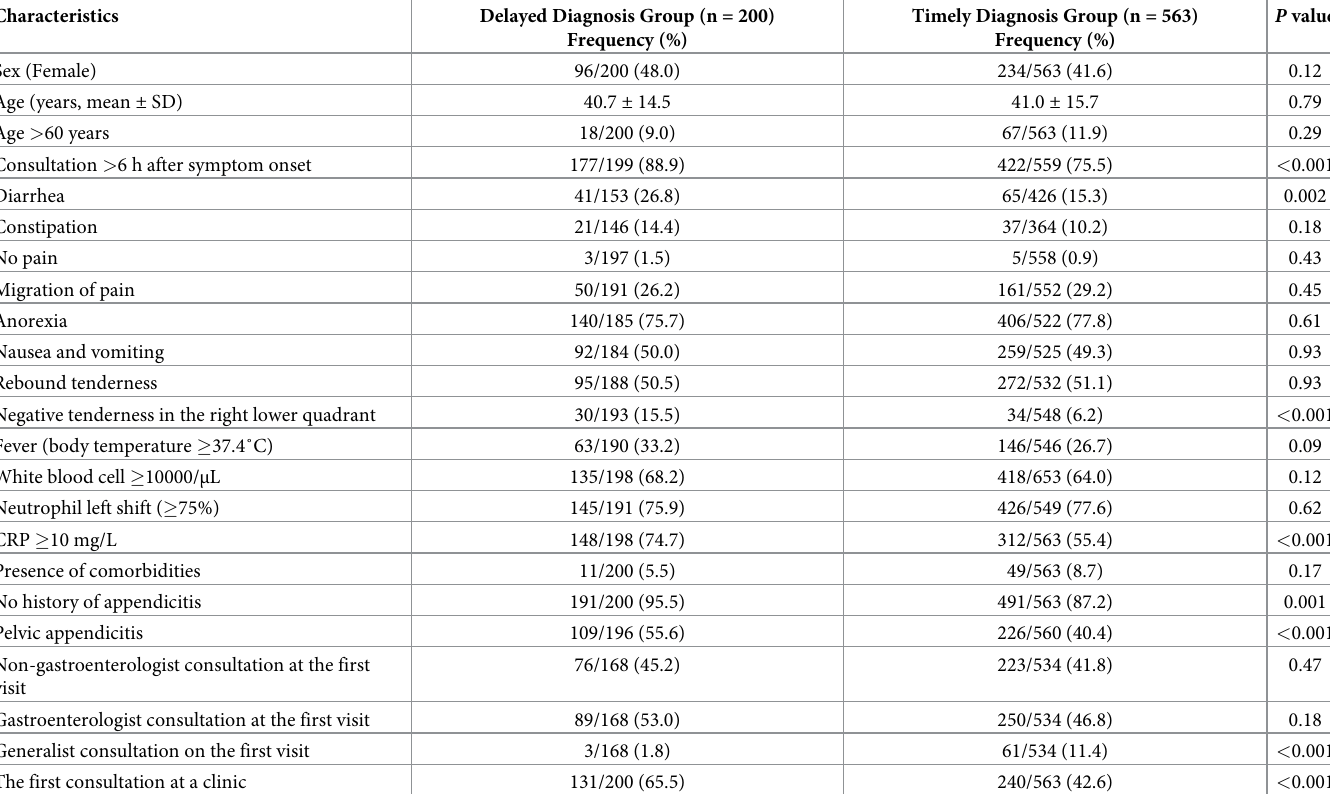
Table 1. Comparison of patient characteristics and factors associated with "delayed" and "timely" diagnosis. Characteristics